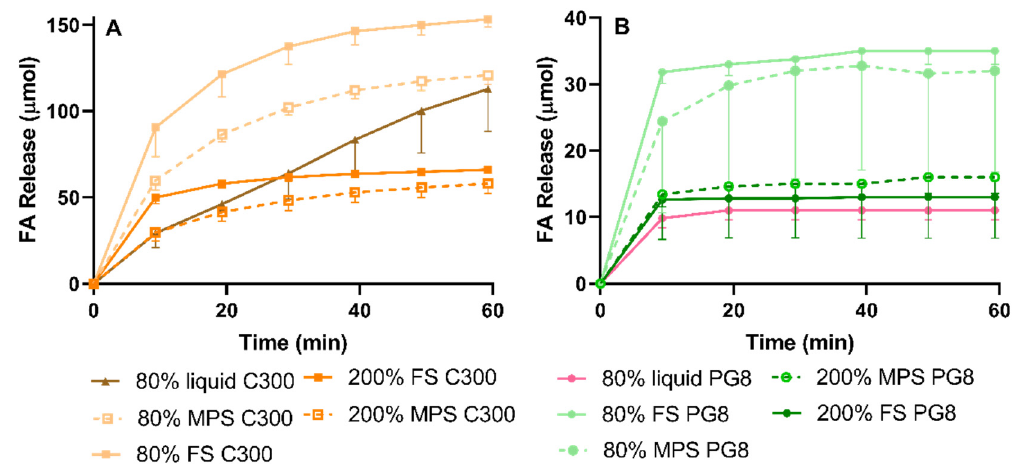
Figure 7. Fatty acid (FA) release-time profile from: ( A ) C300 formulations and ( B ) PG8 formulations, during the intestinal phase of in vitro gastrointestinal (GI) lipolysis in FaSSIF for 60 min, dosed at 3 mg of FEN (mean − SD, n = 3).